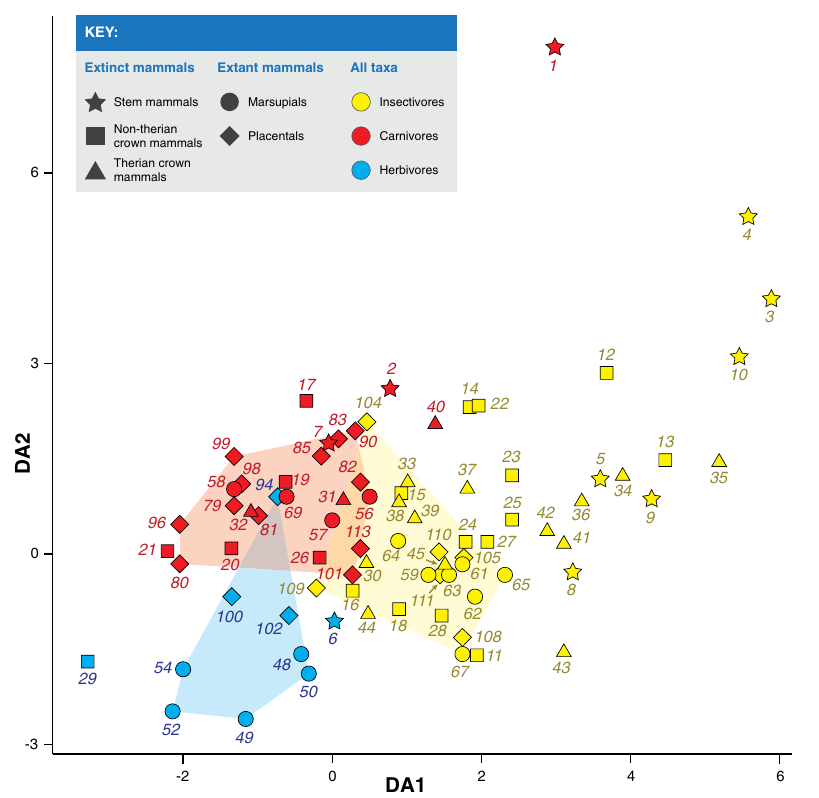
Fig. 4 Phylogenetic fl exible discriminant analysis results, showing discriminant axis 1 (DA1) and two (DA2), of all taxa in this study. Extinct taxa are color coded based on their posterior probability of belonging to one of the established dietary categories. Convex hulls show the position of the extant taxa in the plot and are color coded based on their dietary